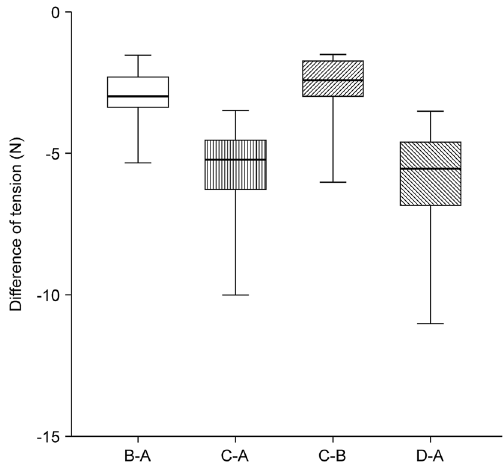
Figure 2. Comparison of mean differences between paired variables of tension change tensiometer data. (a) pre-flap tension at the defect; (b) Type I keystone perforator island flap (KPIF) tension at the defect; (c) Type II KPIF tension at the defect; (d) post-flap tension at the donor.